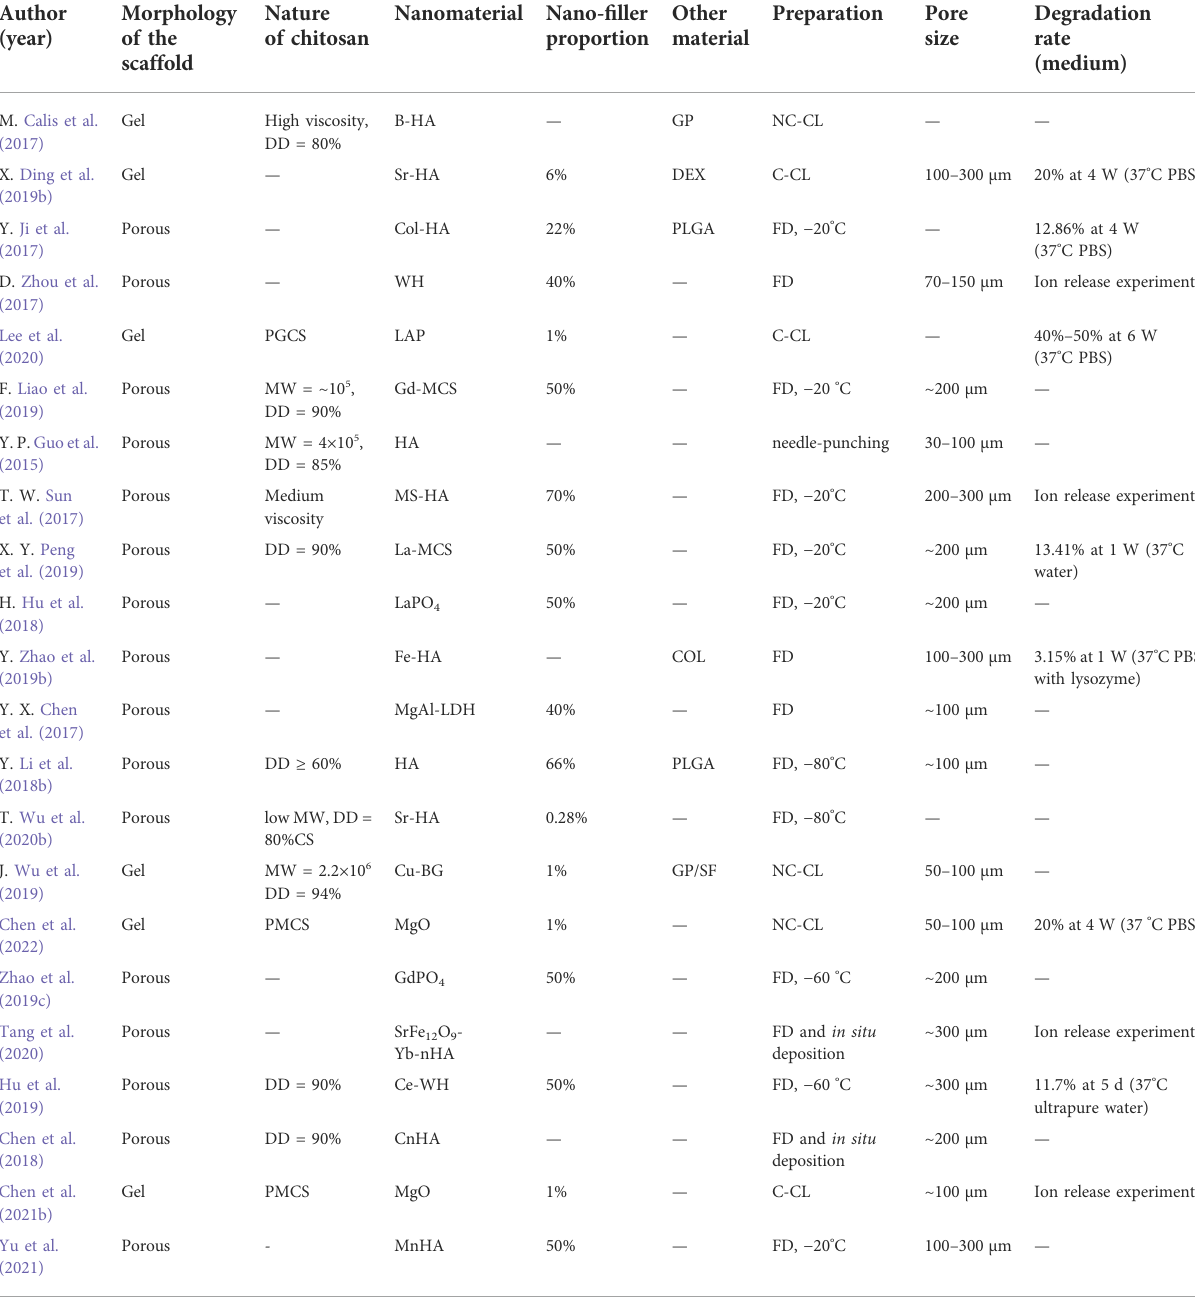
TABLE 5 Characteristics of scaffolds. MW: molecular weight; GP: glycerophosphate; DEX: dextran; Col: collagen; PGCS: phytochemical-grafted chitosan; LAP: laponite; MCS: mesoporous calcium silicate; MS: magnesium silicate; LDH: layered double hydroxide; QCS: NC-CL: non-covalent cross-linking;C-CL:covalentcross-linking;FD:freeze – drying;BG:bioactiveglass;SF:silk fi broin;PMCS:phosphatemodi fi edmethacryloylchitosan; CnHA: carbonated nHA; MnHA: mesoporous